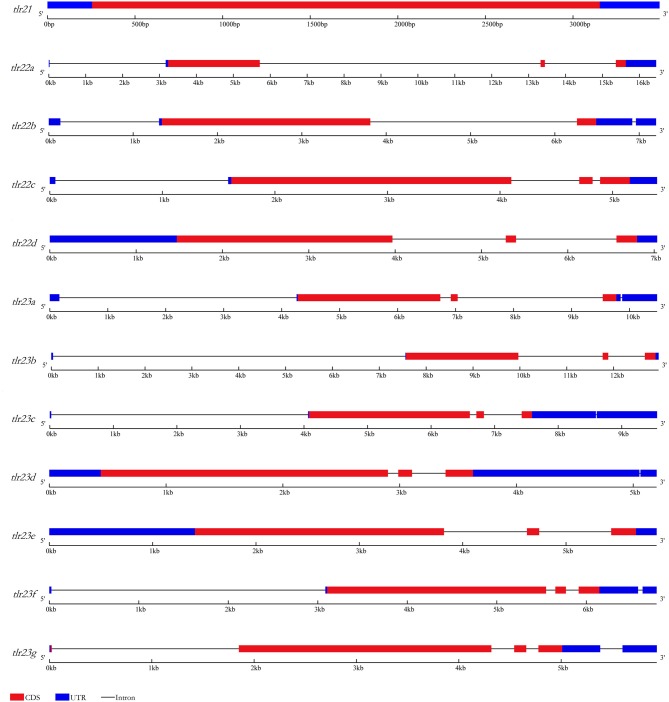
Gene structures of tlr21, tlr22, tlr23 paralogues in B. pectinirostris. Graphical representation of tlr21, tlr22, and tlr23 gene structures. UTRs and CDS are represented in light blue and red, respectively. Introns are indicated by continuous lines.